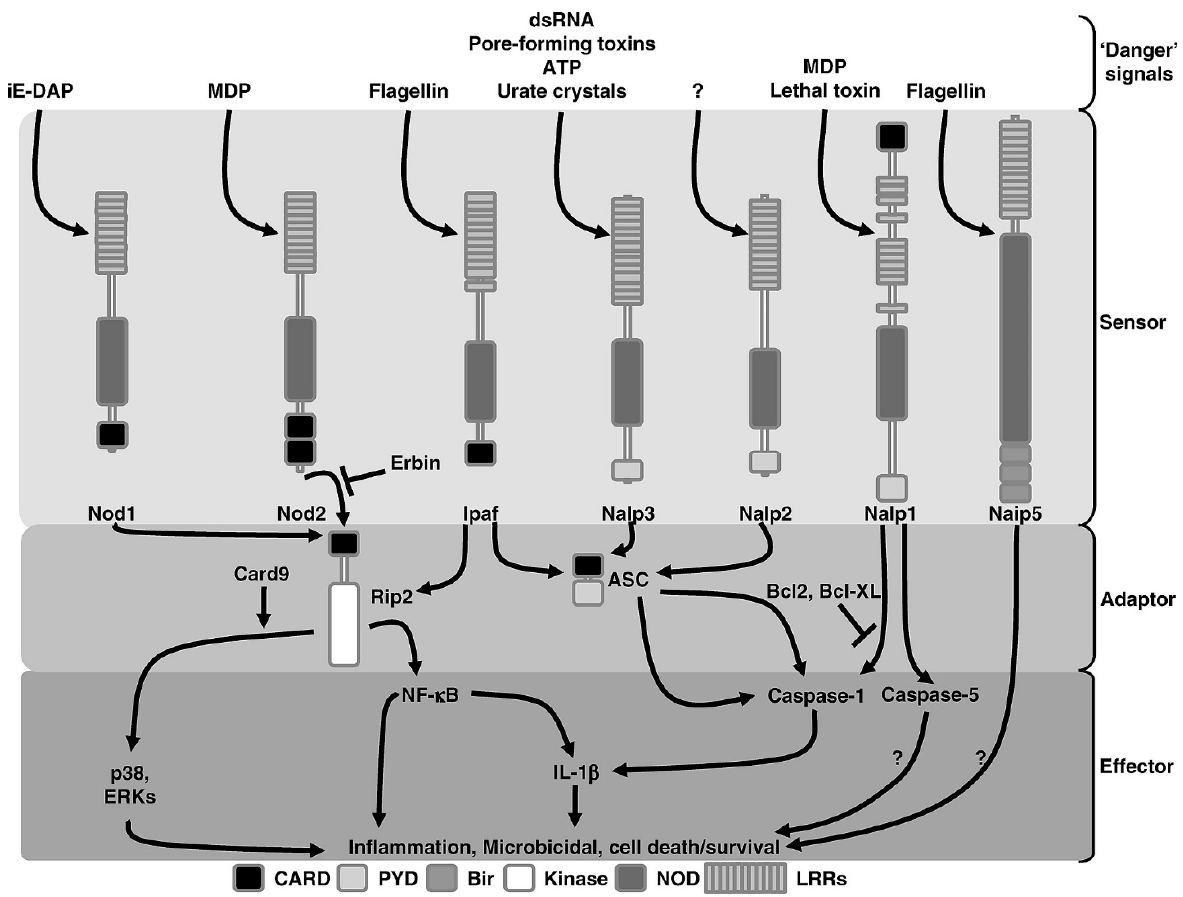
Figure 2. Intracellular Debugging of the NLR Signaling Pathways showing the cellular interconnectivity between PAMPs, cellular sensors, adaptors, and effectors to activate intracellular signaling cascade and stimulation of inflammation ultimate. The intracellular connections between its biomolecules are the basis for nanomedical and nanotechnology discovery against lingering subclinical endometritis.